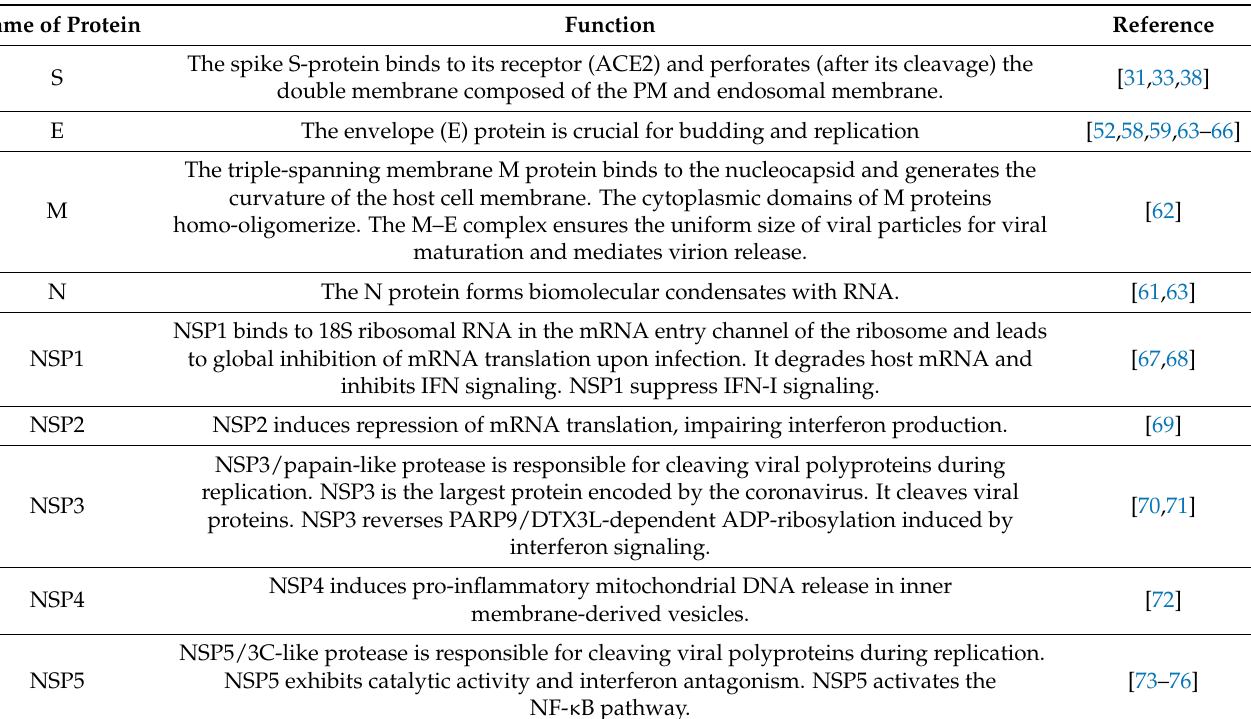
Table 1. Functions of SARS-CoV-2